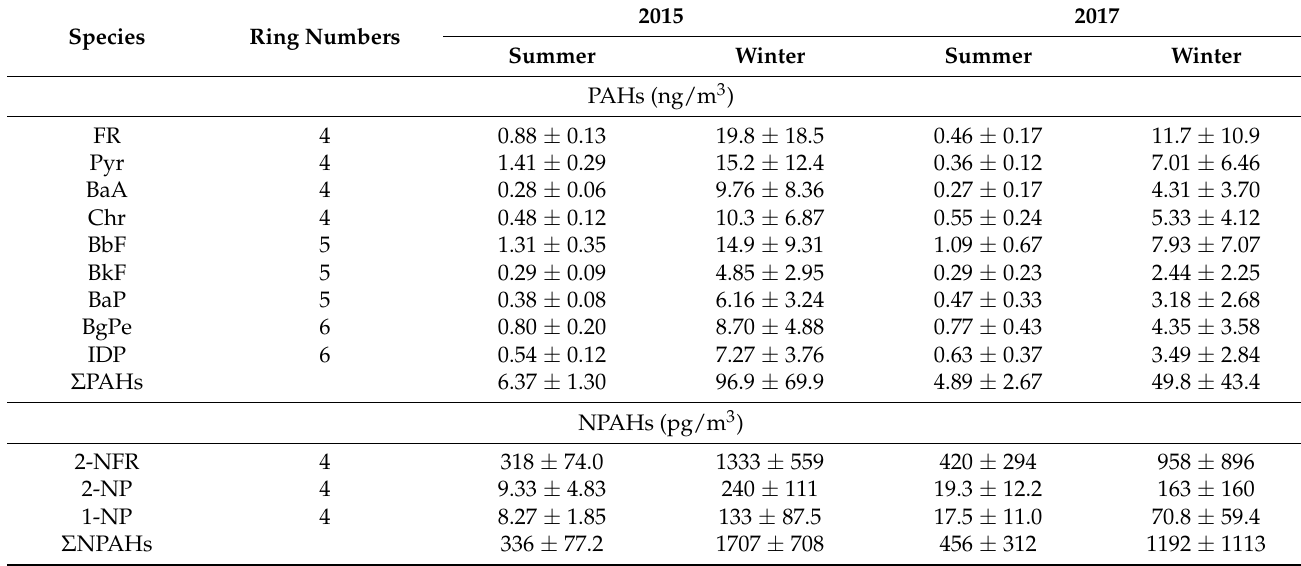
Table 1. The mean concentration and the standard deviation of polycyclic aromatic hydrocarbons (PAH) and three nitro-PAHs (NPAH) in fine particulate matter (PM 2.5 ) for 2015 to